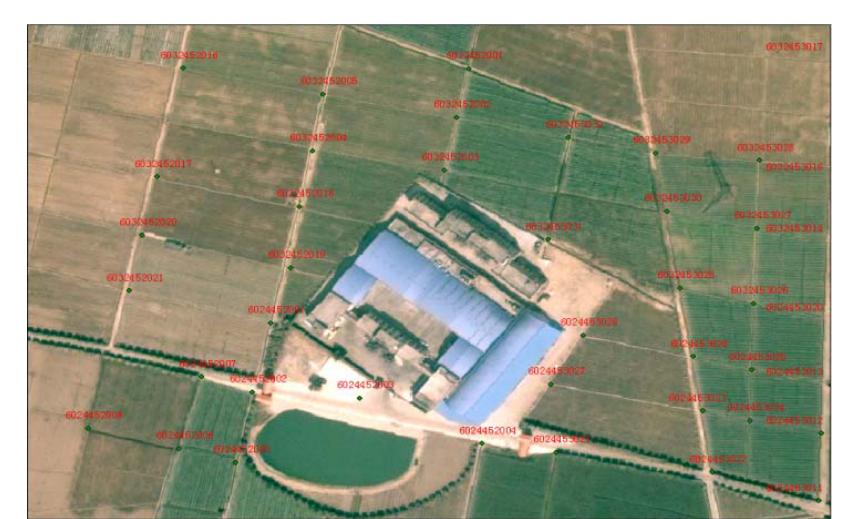
Figure 2: part of the selected feature points in experimental zone (2)Collect the coordinates of feature RTK